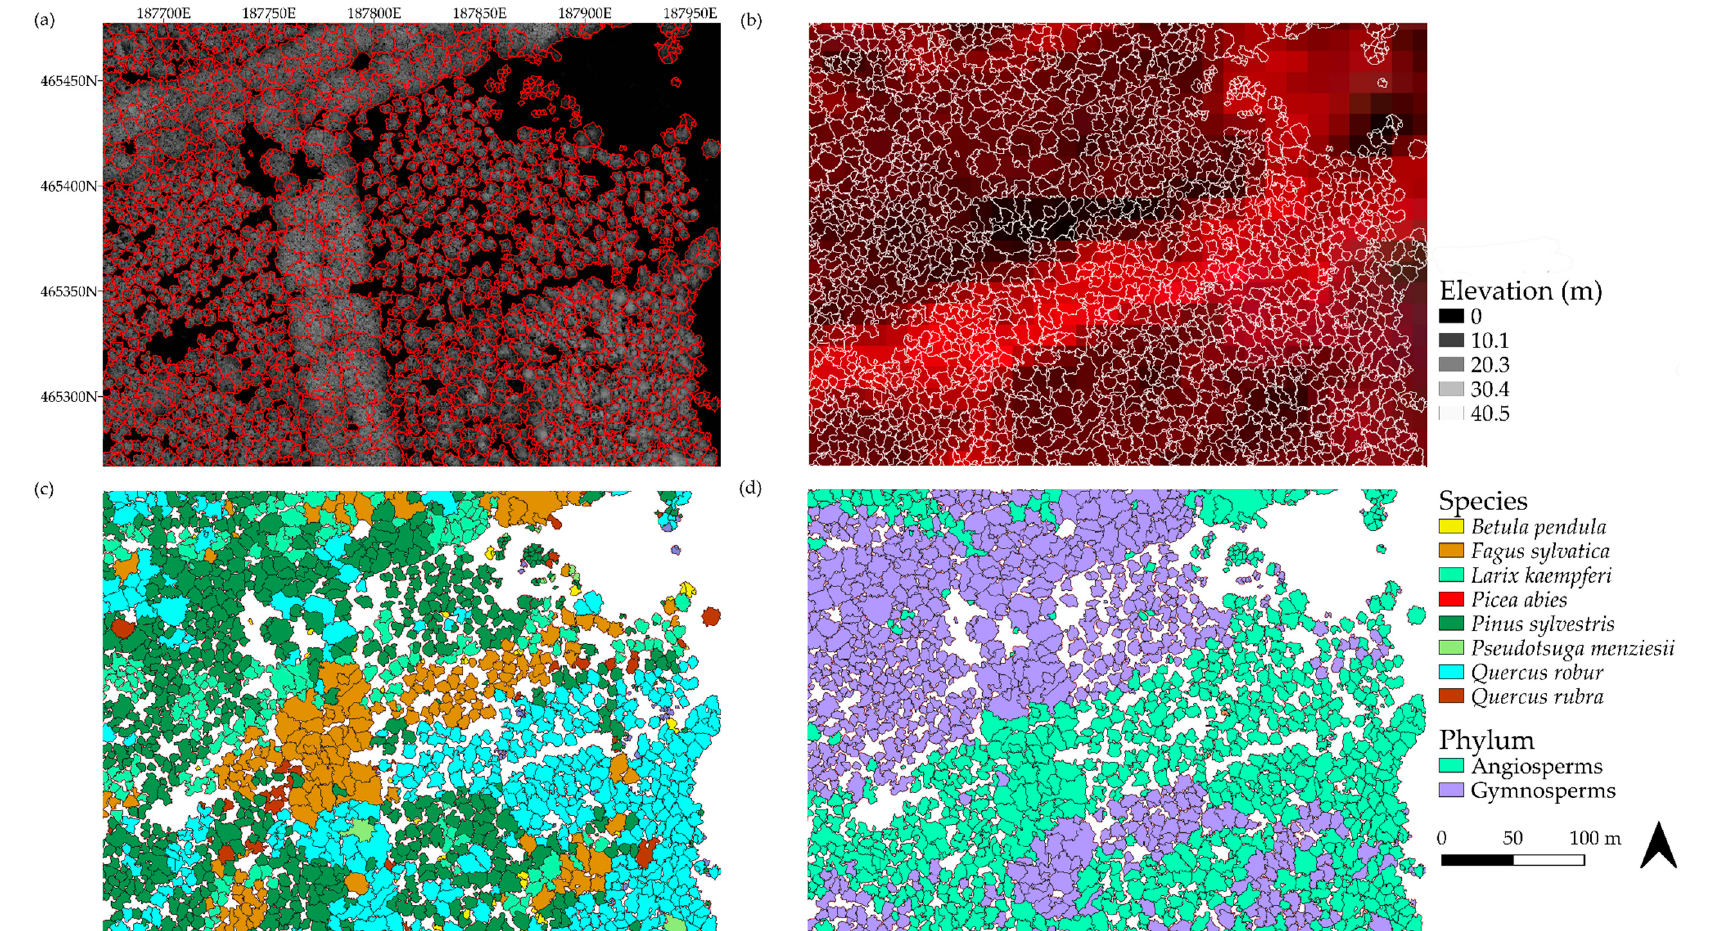
Figure 8. Different steps of our method visualised for a region within the study area. In figure ( a ), the delineated tree crowns are plotted over the canopy height model, in figure ( b ), the delineated crowns are plotted over a false colour composite (composed of near infra-red (NIR), red, and green bands) of the Sentinel-2 image from August 2019. Figure ( c ) shows the tree species classification result for the all variables model (AVS), and ( d ) for the tree phylum classification (AVP). Species and phyla were predicted with the random forest model using selected spectral and crown structural variables.